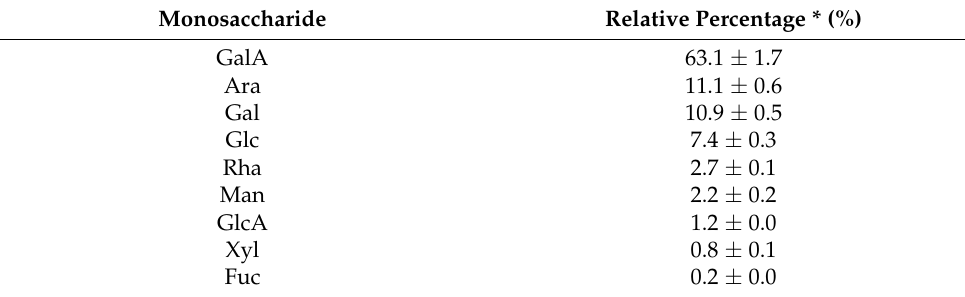
Table 1. Monosaccharide composition of